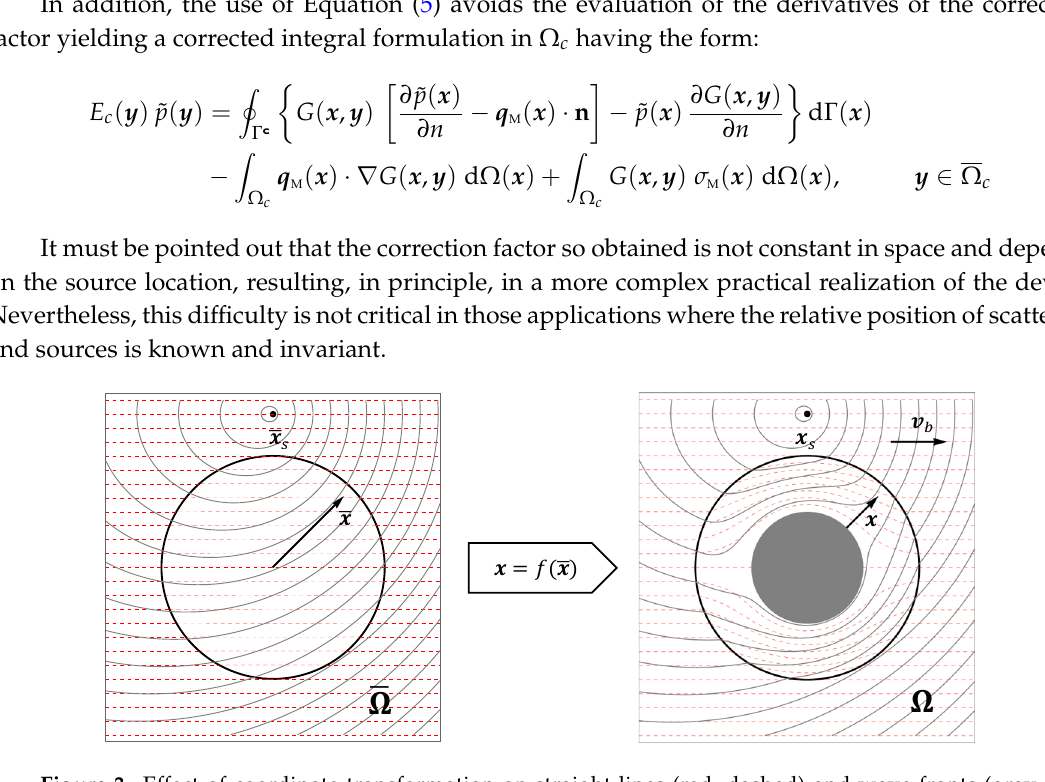
Figure 3. Effect of coordinate transformation on straight lines (red, dashed) and wave fronts (gray, continuous lines) from the virtual domain ¯ Ω to the physical domain Ω . Object and source moving with velocity v b